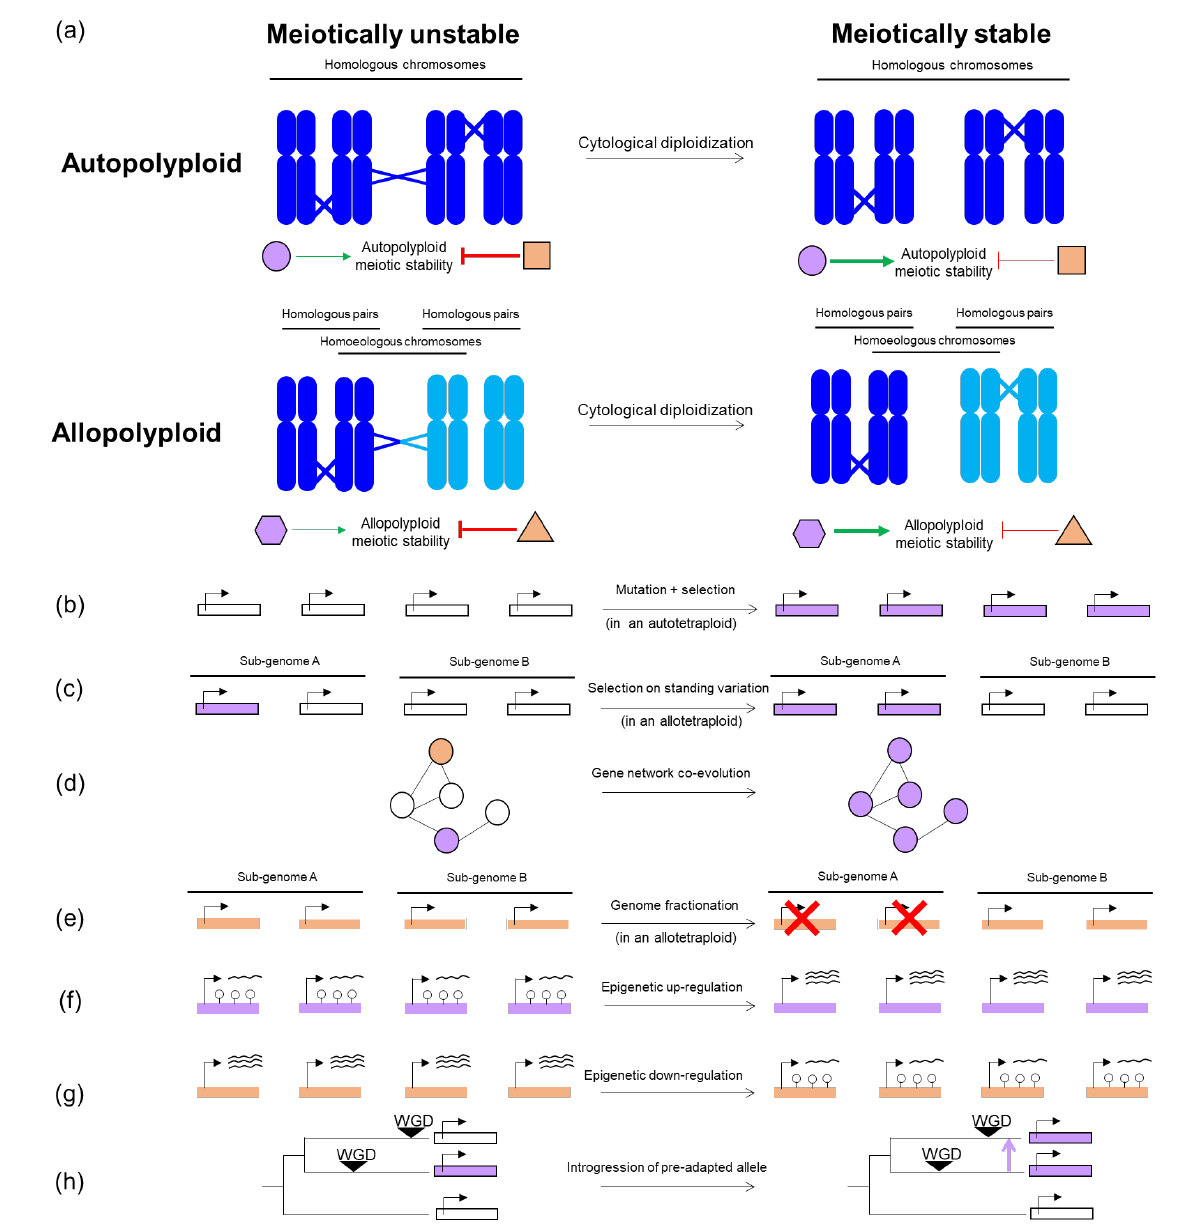
Figure 1. Mechanisms ( a ) and evolutionary routes ( b–h ) to meiotic stabilization in auto- and allopolyploids. Genes and factors that promote or counteract polyploid meiotic stability are shown in violet or orange, respectively, while genes or factors with undetermined effect on meiotic stability are shown in white. Different set of shapes are used to represent auto- and allopolyploid factors (circle/square and hexagon/triangle, respectively) to indicate that those factors are not expected to coincide for the two kinds of polyploids. ( a ) Schematic representation of a putative tetraploid organism (4x=2n=4), both as an autopolyploid and allopolyploid, before and after undergoing cytological diploidization (with and without crossovers involving more than two chromosomes, respectively). Homologous chromosomes from the same sub-genome are shown in the same color (either dark or light blue), while homoeologs are shown in different color (different sub-genomes). ( b–h ) Schematic representations of putative genes (rectangles) and factors (shapes including circles, squares, hexagons or triangles) taking different routes to contribute to meiotic stabilization. Genes are shown in four copies to represent the four possible alleles that can coexist in a tetraploid. When relevant for allopolyploidy cases, two different sub-genomes are represented.